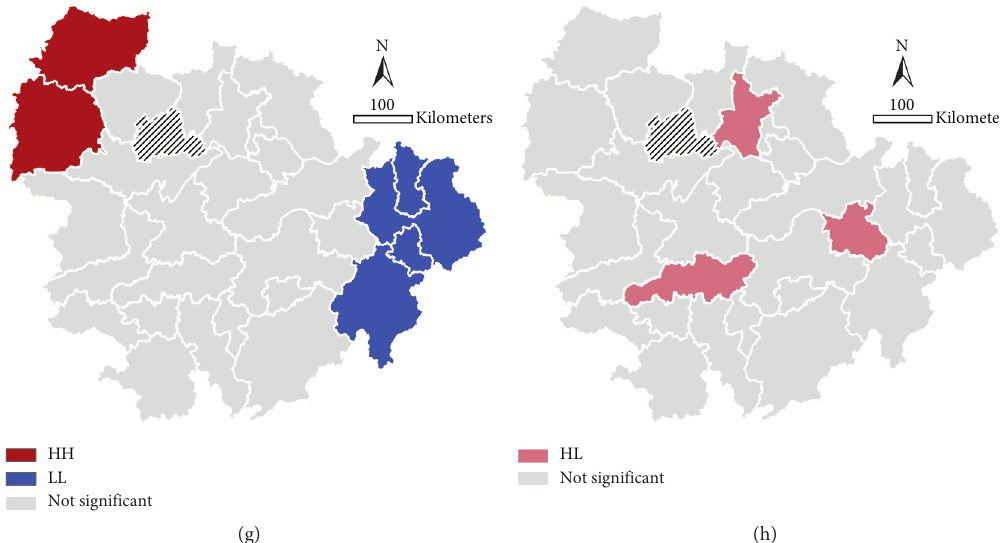
Figure 10: LISA clustering distribution of dominant elements of urban resilience: (a) E 2; (b) E 3; (c) S 2; (d) N 2; (e) N 3; (f) N 4; (g) N 5; (h) P